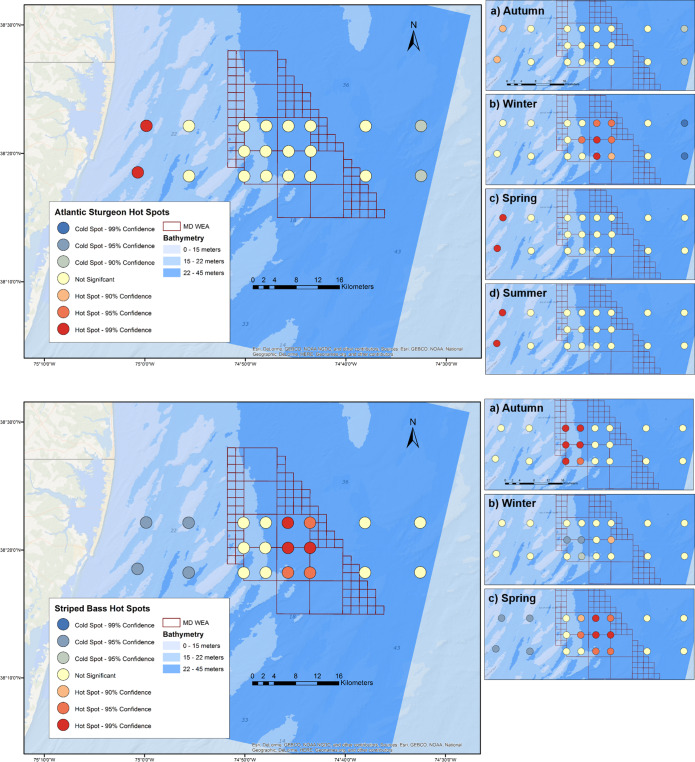
Hot spots of species occurrence across the acoustic receiver
array.Results reflect annual (left) and seasonal (insets, right) numbers of
individual Atlantic sturgeon (top) and striped bass (bottom) detected
per receiver.